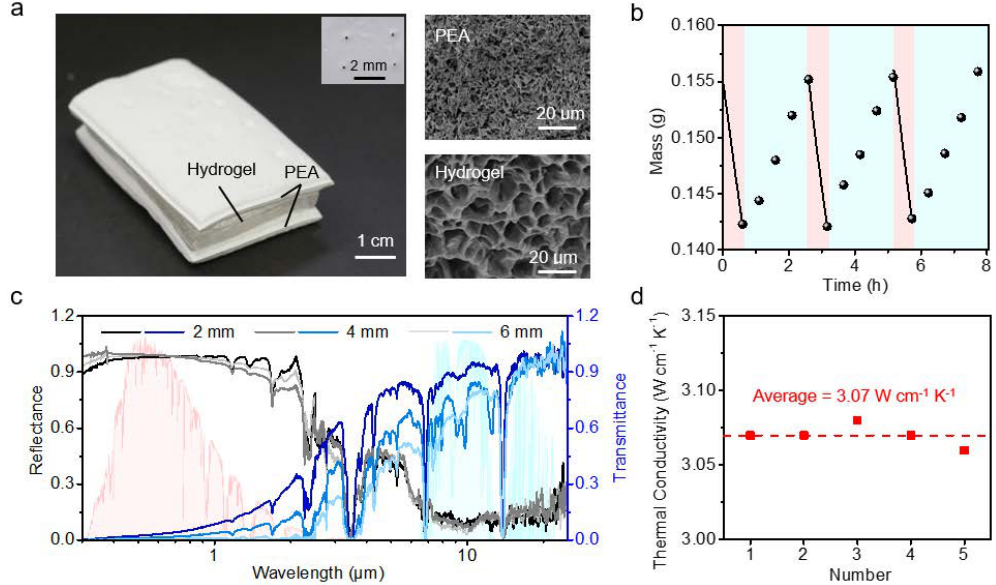
Figure 2. Structure and characterizations of the PHP membrane. ( a ) Photograph of a PHP membrane with a size of ~4 cm × 6 cm. SEM images of a PEA sample ( top right ) and hydrogel sample ( bottom right ). ( b ) Mass changes of a hydrogel (~4 cm × 1 cm × 0.5 cm) during repeating evaporation and regeneration processes. ( c ) Hemispherical transmittance and reflectance of the 2 mm PEA, 4 mm PEA, and 6 mm PEA samples, along with the normalized AM 1.5 solar spectrum, and the transparent atmospheric window in the mid-infrared spectrum. ( d ) Thermal conductivity of a PEA sample.